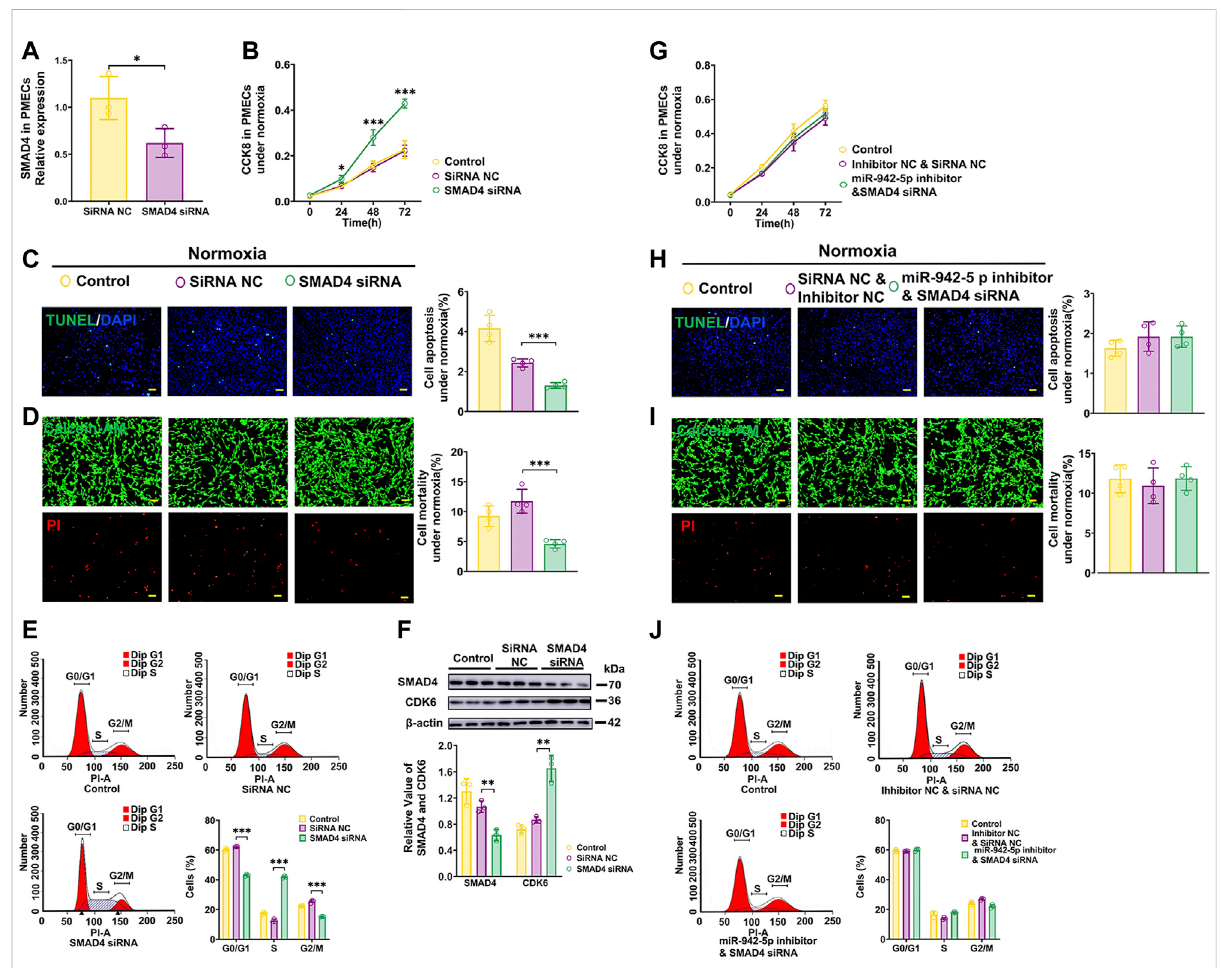
FIGURE 6 Effects of SMAD4 on the proliferation, apoptosis and cell cycle of PMECs. (A) Expression levels of SMAD4 in PMECs treated with SMAD4 siRNA ( n = 3). (B – E) Cell proliferation analysis, apoptosis analysis, mortality analysis ( n = 4) and cell cycle analysis ( n = 3) of PMECs with transfecting SMAD4 siRNA under normoxia. (F) The expression of CDK6 in PMECs transfected with SMAD4 siRNA was analyzed by WB ( n = 3). (G – J) Cell proliferation analysis, apoptosis analysis, mortality analysis ( n = 4) and cell cycle analysis ( n = 3) of PMECs with co-transfecting miR-942-5p inhibitor and SMAD4 siRNA under normoxia. All data are presented as the mean ± SEM. (scale bar, 100 μ m). * p < 0.05; ** p < 0.01; *** p <